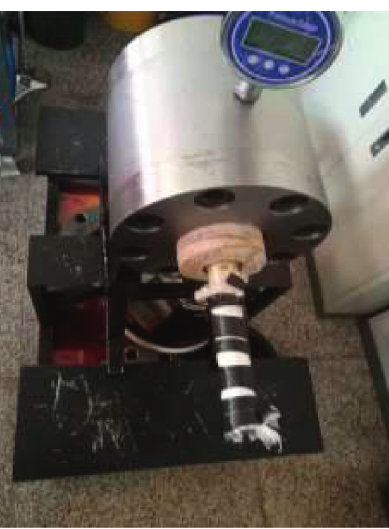
Figure 7: Schematic diagram of the confining pressure